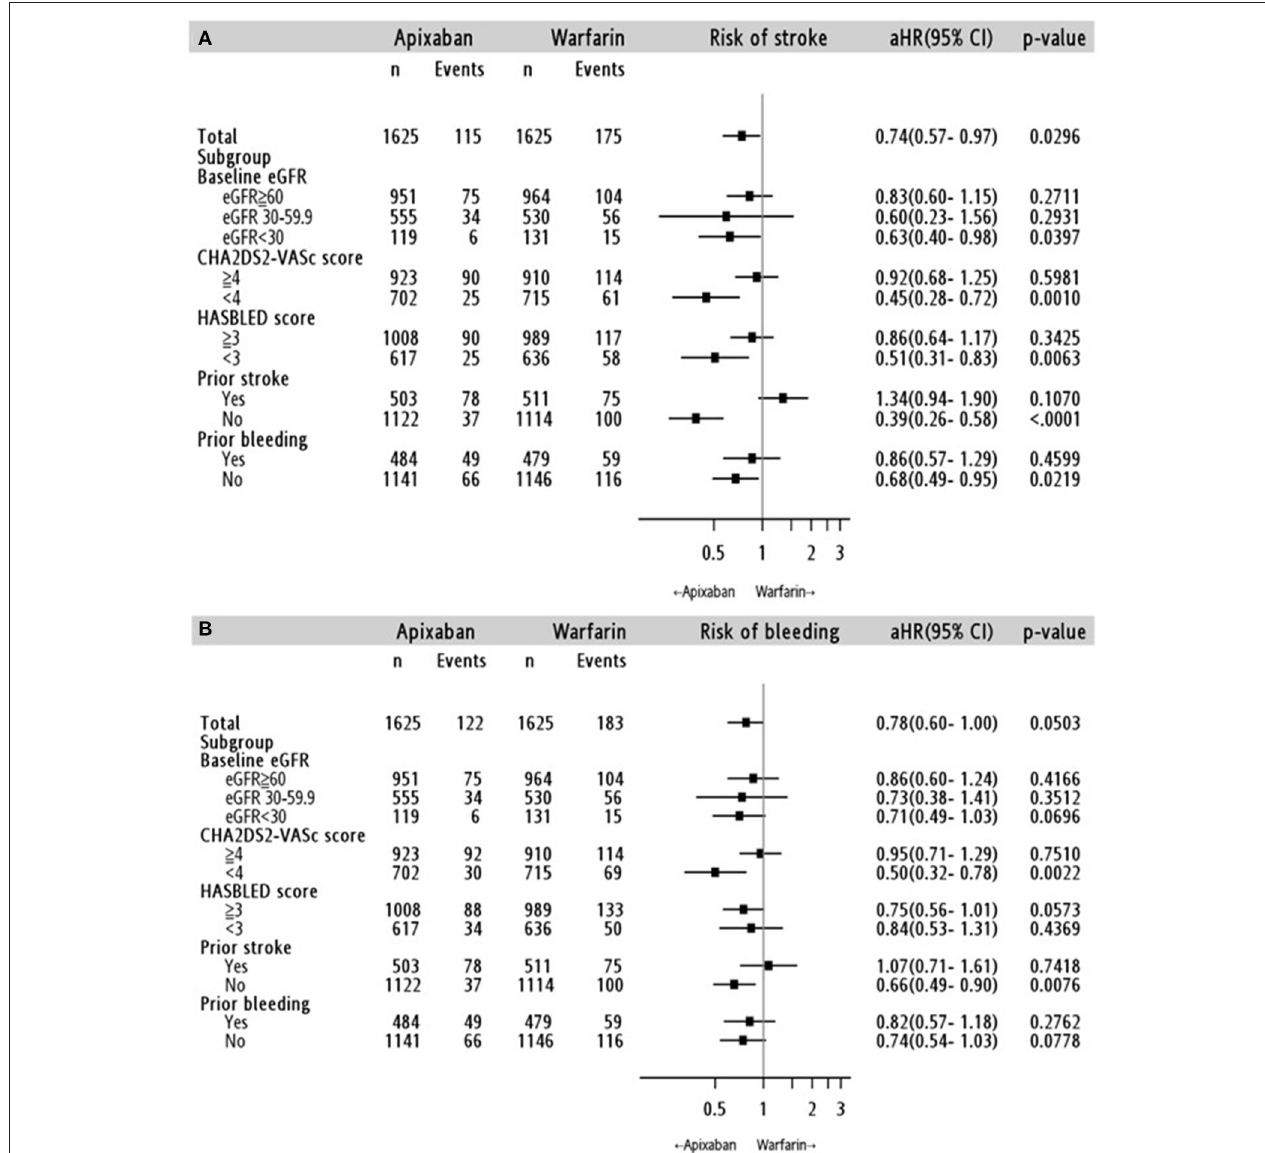
FIGURE 3 | Stratified analyses for the risk of (A) ischemic stroke/systemic embolism and (B) major bleeding in the apixaban-warfarin matched cohort. aHR: adjusted hazard ratio; 95% CI, 95% confidence interval; eGFR: estimated glomerular filtration rate (ml/min/1.73 m 2